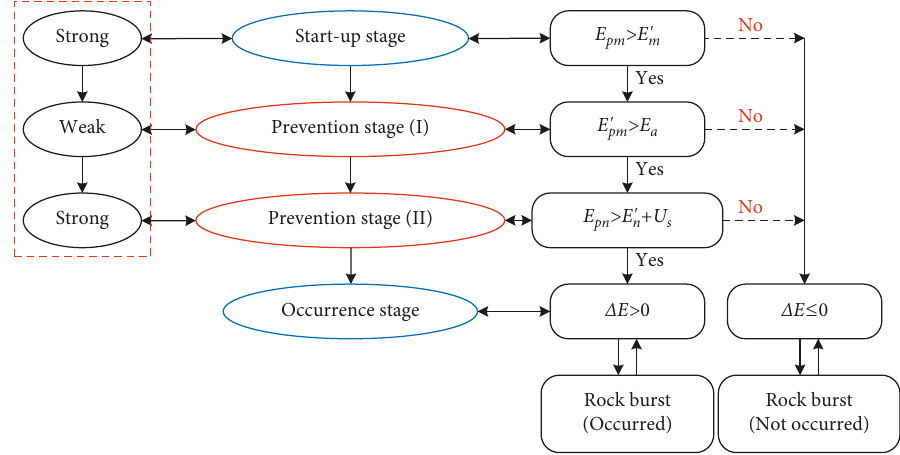
Figure 9: The occurrence process of rock burst in roadway